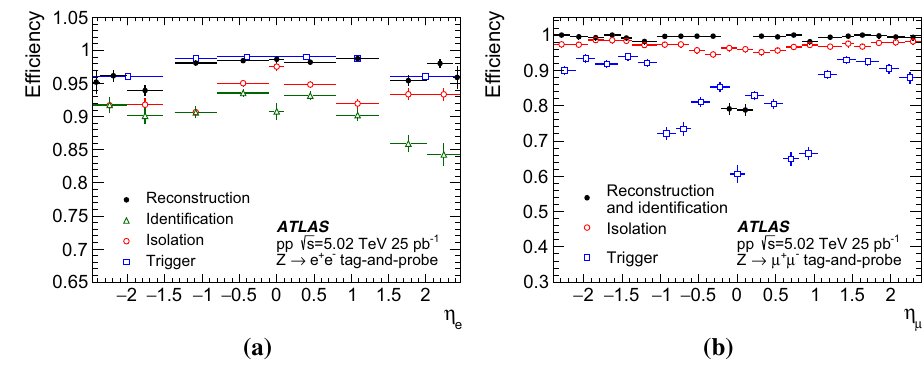
Fig. 1 Efficiencies of reconstruction, identification, isolation and